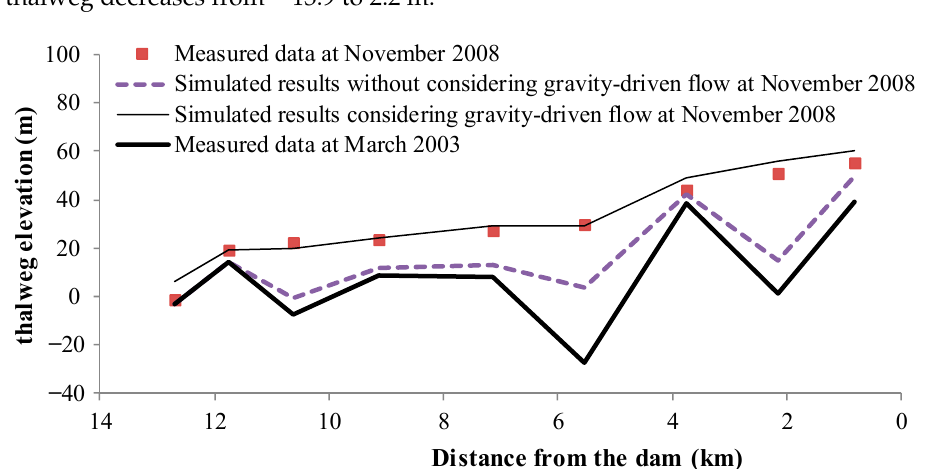
Figure 12. Comparisons of the sediment distributions on a typical cross ‐ section between the observations and simulated results. (a) on section S30+1; (b) on section S32; (c) on section S34; (d) on section S37.